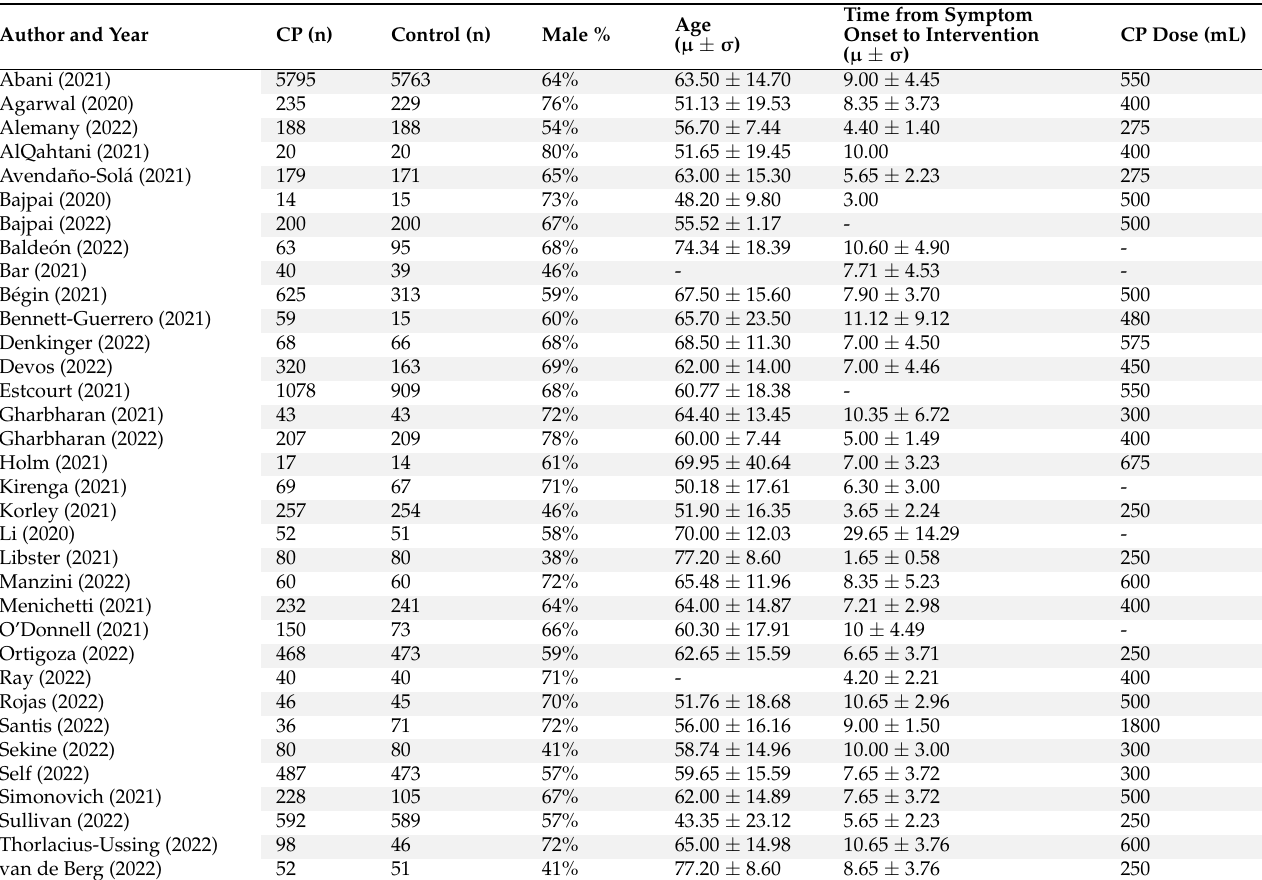
Table 2. Intervention characteristics of the included